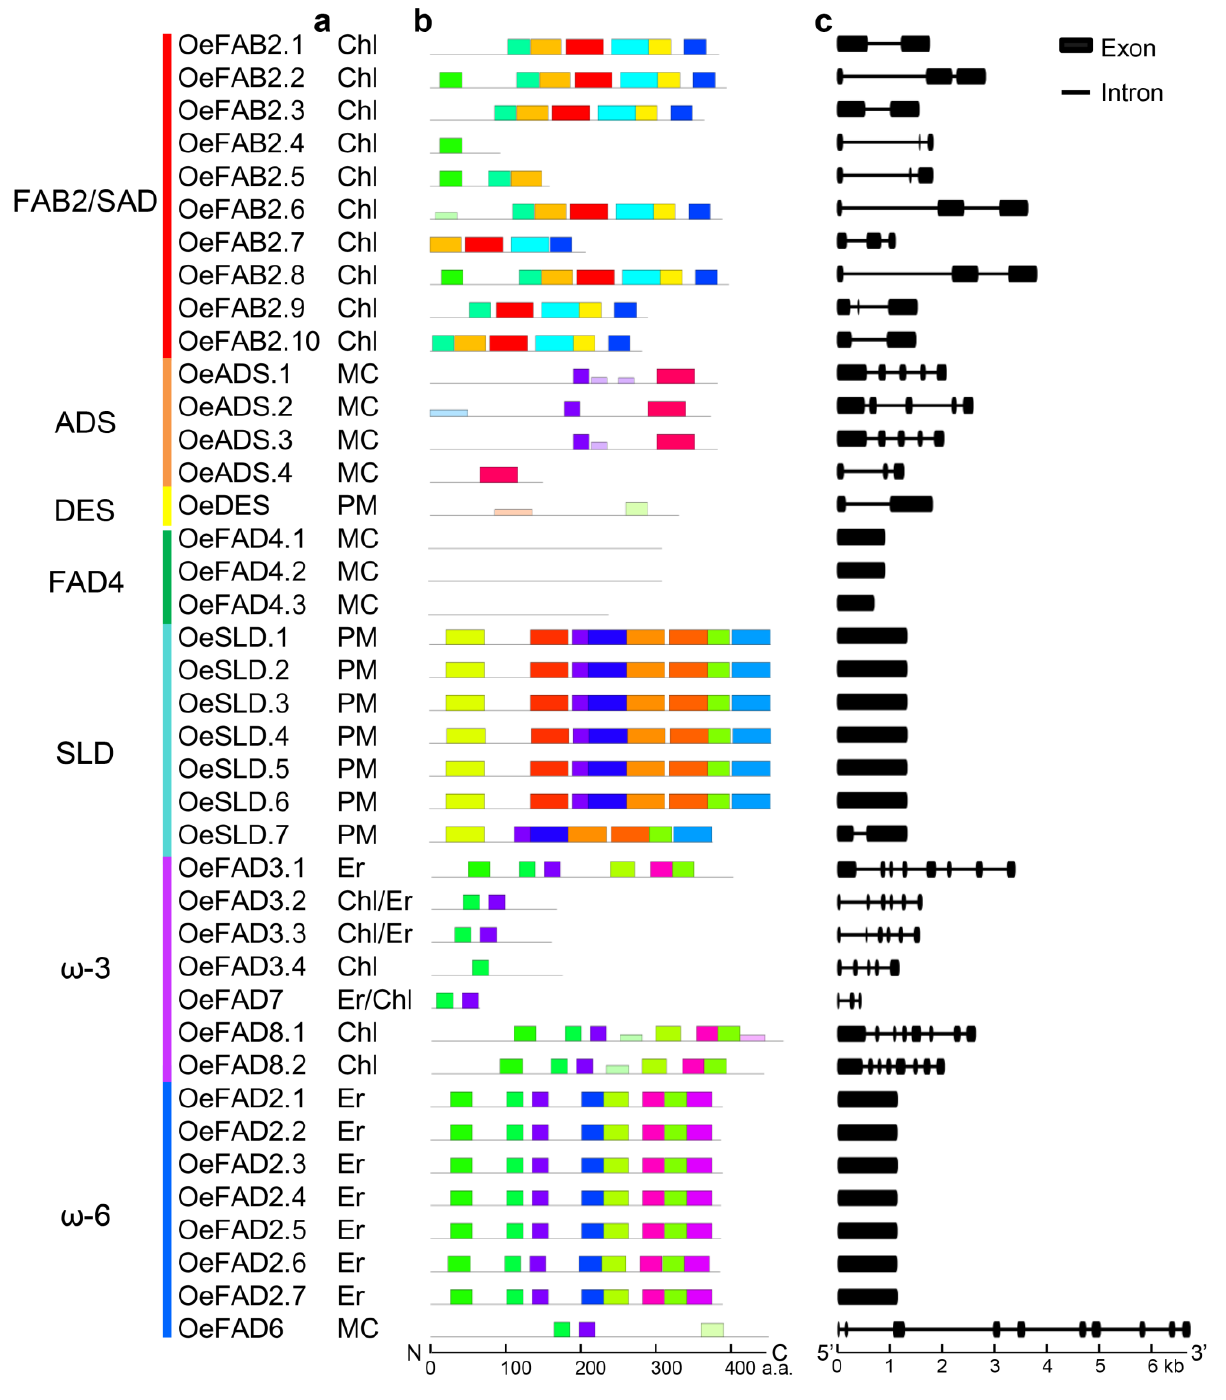
Figure 2. Analysis of subcellular localization, motif composition and exon/intron structure. Predicted subcellular localization ( a ), conserved motif ( b ) and gene structure ( c ) of FAD genes were conducted by Softberry (http://www.softberry.com/ accessed on 31 March 2022), MEME (https://meme-suite.org/meme/ accessed on 31 March 2022) and Gene Structure Display Server 2.0 (http://gsds.gao-lab.org/ accessed on 31 March 2022), respectively. The boxes with different colors represented various motifs. Chl, chloroplast; MC, membrane bound chloroplast; PM, plasma membrane; Er, endoplasmic reticulum.